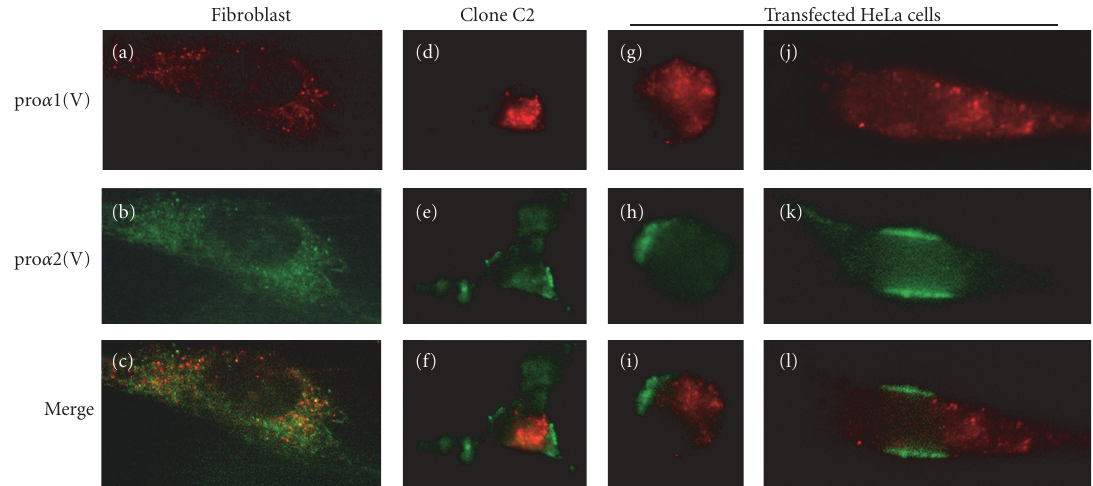
Figure 7: Double immunofluorescence staining was performed using monoclonal antibody against human pro α 1(V) chain (18G5) (a, d, g, j) and rabbit polyclonal pro α 2(V) chain (b, e, h, m), and merge (c, f, i, l). (a, b, c) human dermal fibroblasts; (d, e, f) clone 22 cells; (g)– (l) HeLa cells transiently transfected with human pro α 1(V) and pro α 2(V) constructs. Double immunofluorescence staining shows distinct intracellular distribution of the pro α (V) chains in round (g)–(i) and spreading (j, k, l) HeLa cells. Magnification: